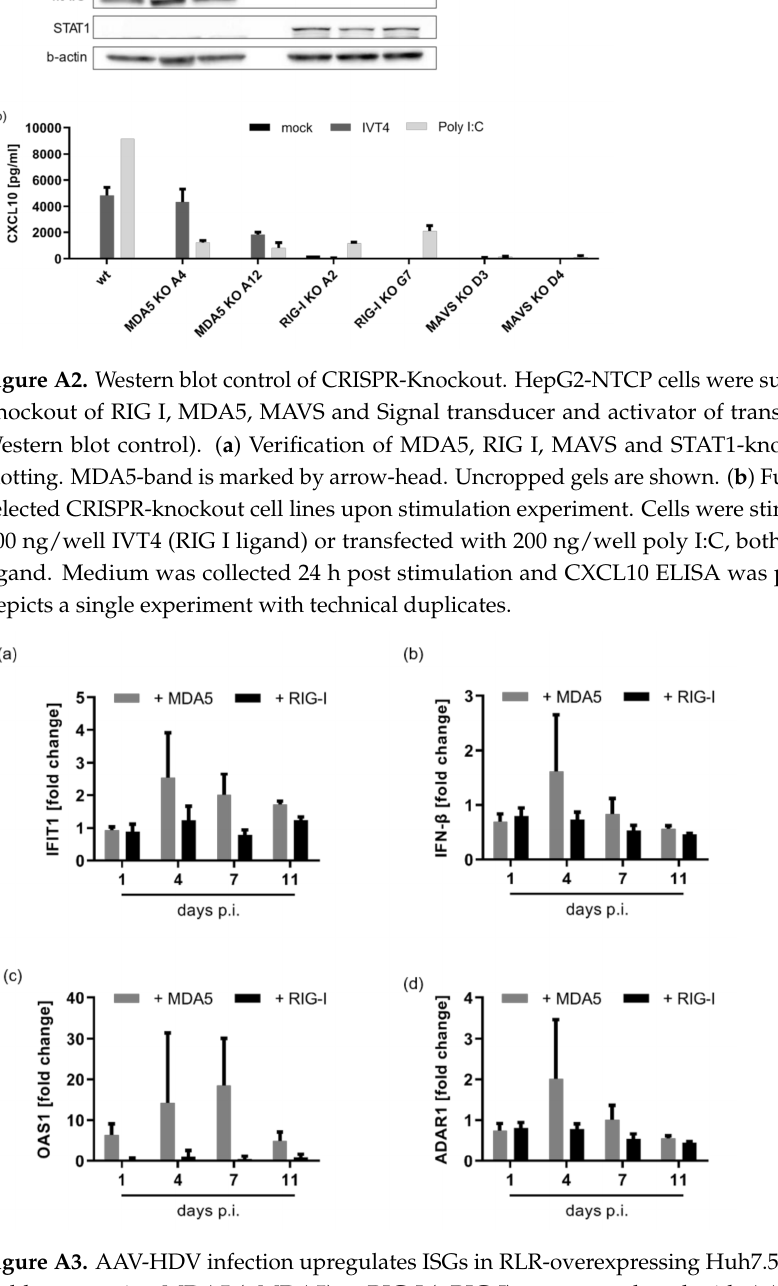
Figure A3. AAV-HDV infection upregulates ISGs in RLR-overexpressing Huh7.5 cells. Huh7.5 cells stably expressing MDA5 (+MDA5) or RIG-I (+RIG-I) were transduced with AAV-HDV. RNA was extracted at indicated days and subjected to qRT-PCR. Upregulation of the ISGs IFIT1 ( a ), IFN- β ( b ), OAS1 ( c ) and ADAR1 ( d ) is given as fold induction relative to cells not expressing RLRs at indicated timepoints. Graph depicts a single experiment in